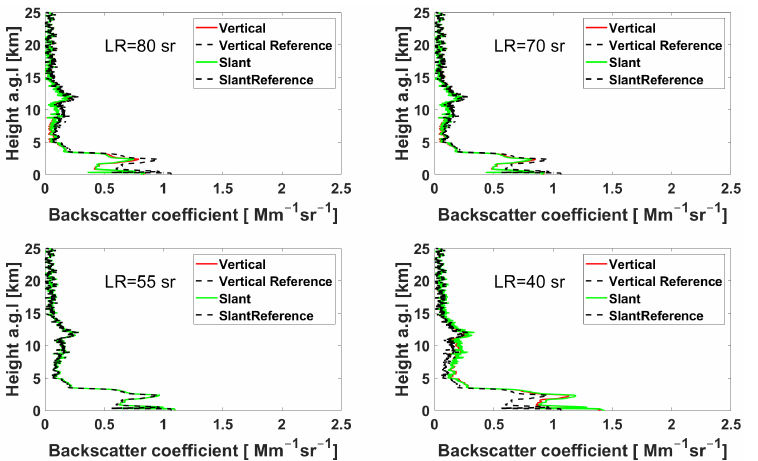
Figure 1. The input (dashed line) and retrieved (red and green line) backscatter coefficient profiles for different values of the LiDAR ratio with an input LiDAR ratio of 55 sr for the simulation